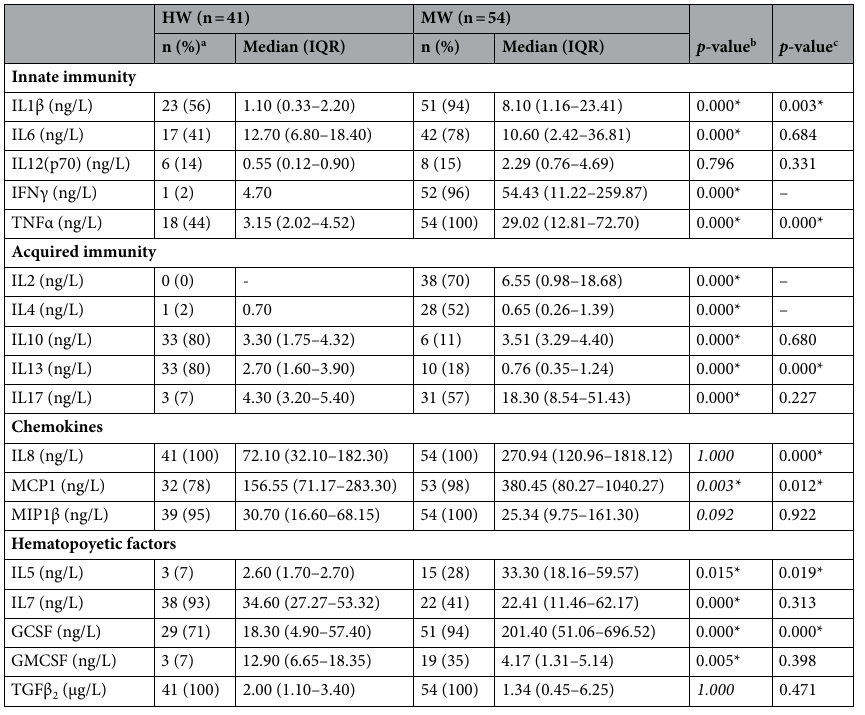
Table 4. Frequency and concentration of immune factors detected in milk samples from healthy women (HW) and mastitis cases (MW). GCSF granulocyte colony-stimulating factor, GMCSF granulocyte– macrophage colony-stimulating factor, INFγ interferon-γ, IL interleukin, MCP1 macrophage-monocyte chemoattractant protein-1, MIP1β macrophage inflammatory protein-1β, TGFβ 2 transforming growth factor-β 2 , TNFα tumor necrosis factor-α. *Statistically significant difference, p < 0.05. a n (%): number (percentage) of samples in which the immunological compound was detected (relative frequency of detection). b χ 2 or Fisher tests (in italics) were used to determine a possible association between the breast health status and the immunological compound. FDR-adjusted p -values. c Wilcoxon rank sum tests were used to determine differences in the concentration detected of each immunological compound between samples from the HW and MW groups. FDR-adjusted p